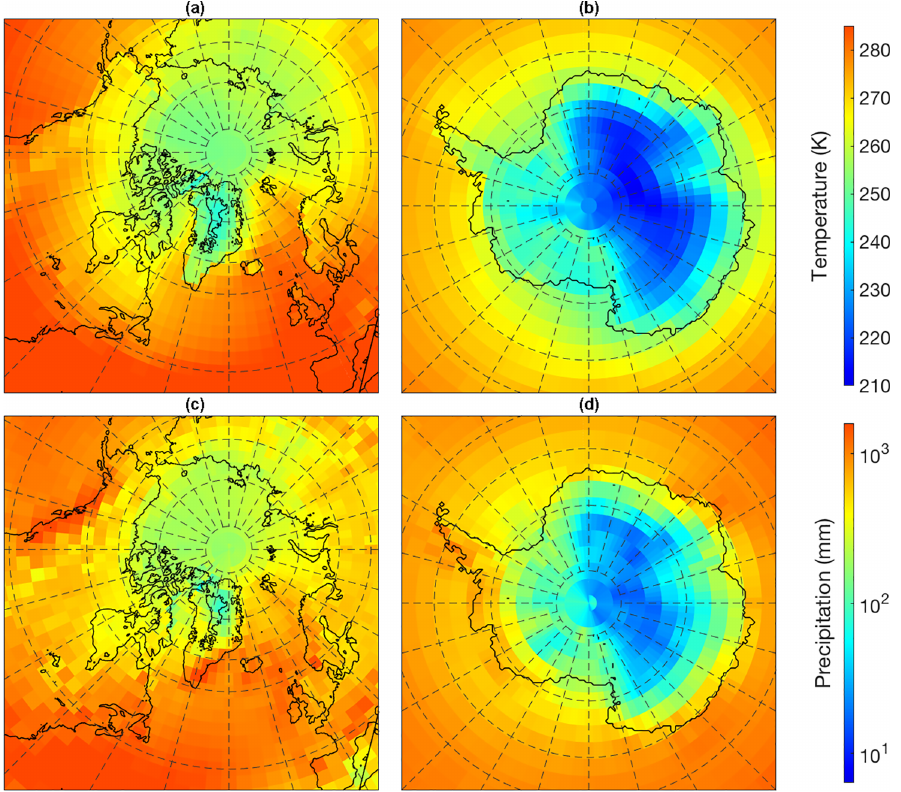
Figure 2. Annual mean 2m temperature for the Northern Hemisphere (a) and Antarctica (b) and the total annual precipitation (c, d) calculated with HadCM3 in the PI_Control experiment (Singarayer and Valdes,